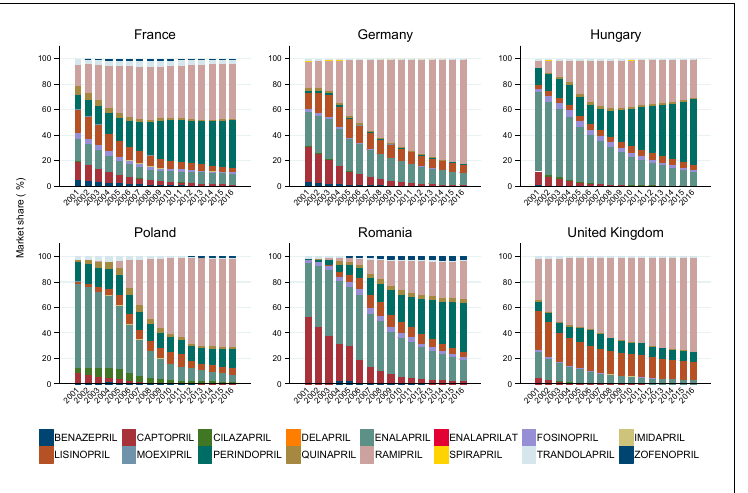
Figure 3. Volume share of ACE inhibitors (combination drugs and single-drug preparations) in six European countries between 2001 and 2016.